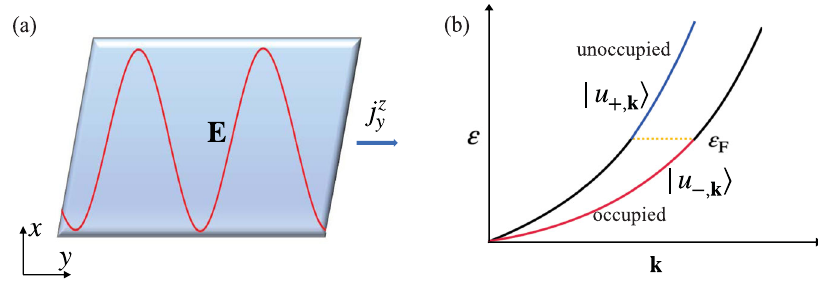
Fig. 1 Schematic of the two-dimensional two-band system. a A two-dimensional system under consideration. The inhomogeneous in-plane electric fi eld E is applied. Spin Hall current j z y fl ows perpendicular to the polarization direction of the applied fi eld. b Energy bands model in one quadrant with the Fermi energy ε F higher than the nodal energy. The temperate is taken as zero. j u i are the periodic part of Bloch wave functions for the upper unoccupied band ± ; k and the lower occupied band, respectively.